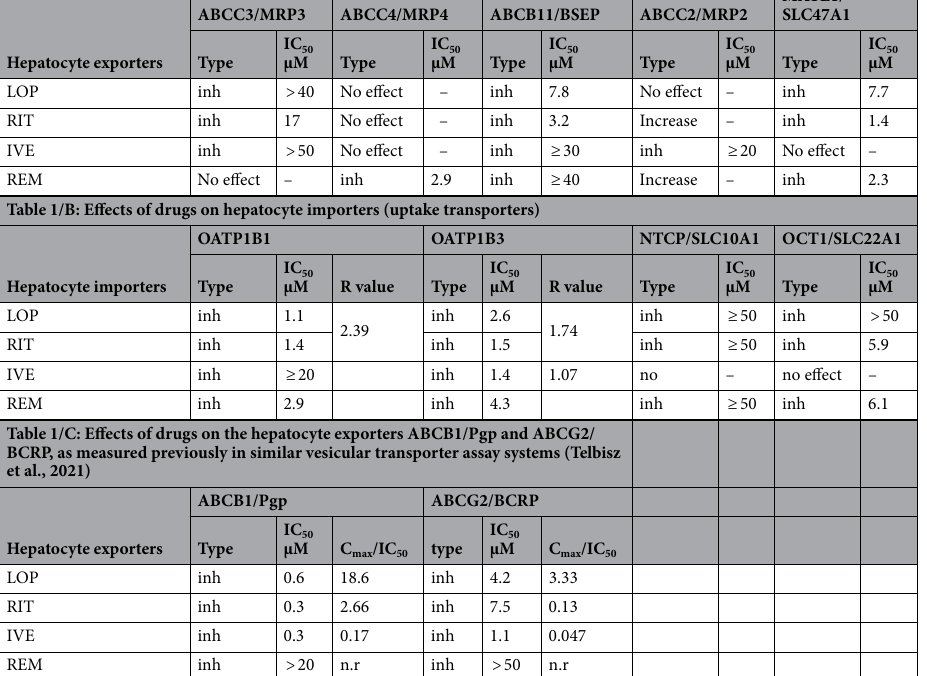
Table 1/A. Effects of drugs on hepatocyte exporters (basolateral: MRP3 and MRP4, apical: BSEP, MRP2 and MATE1)